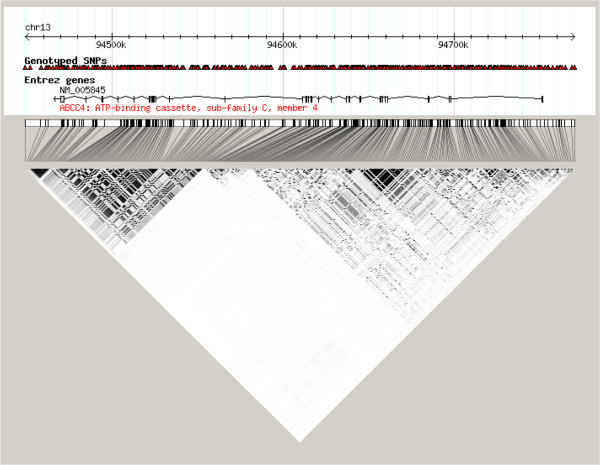
Pairwise r2 among the 327 SNPs across the gene ABCC4. The color of each box signifies the value of r2 between SNPs alleles, with the black indicating strongest relationship between a pair of marks (1 = black, 0 = white).